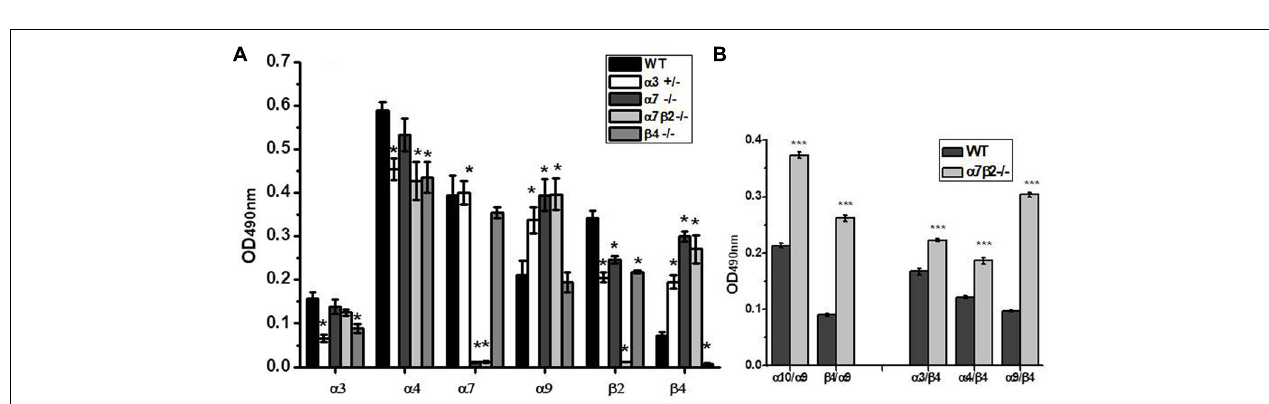
FIGURE 7 | The nAChR subunit composition (A) and subunit combinations (B) in mitochondria of the wild-type (WT) and α 7 β 2–/– mice. Each column corresponds to mean ± SE, five mice per genotype; ∗ p < 0.05 compared to WT. The designations along abscissa correspond to the antibody combinations in sandwich ELISA: